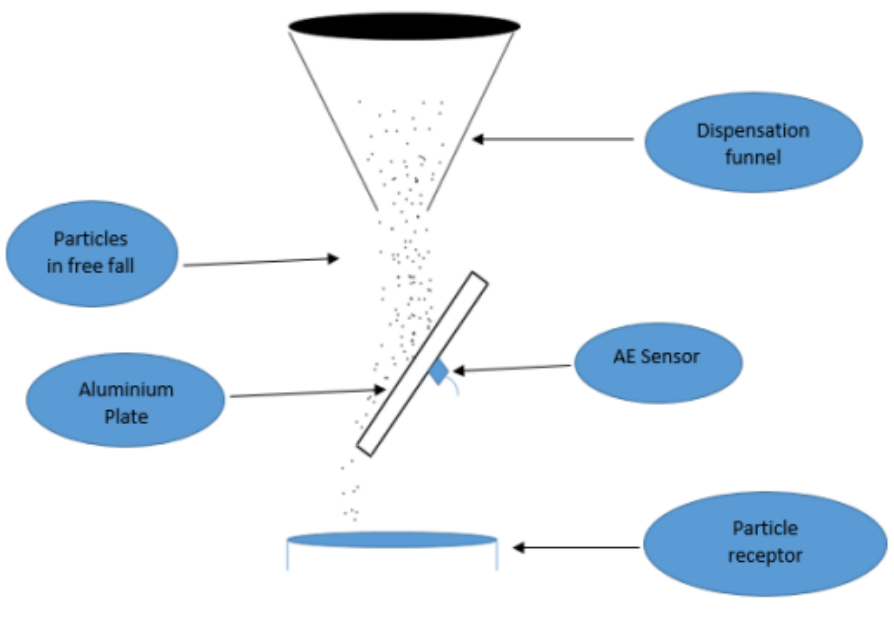
Figure 6. Image of experimental rig [27].